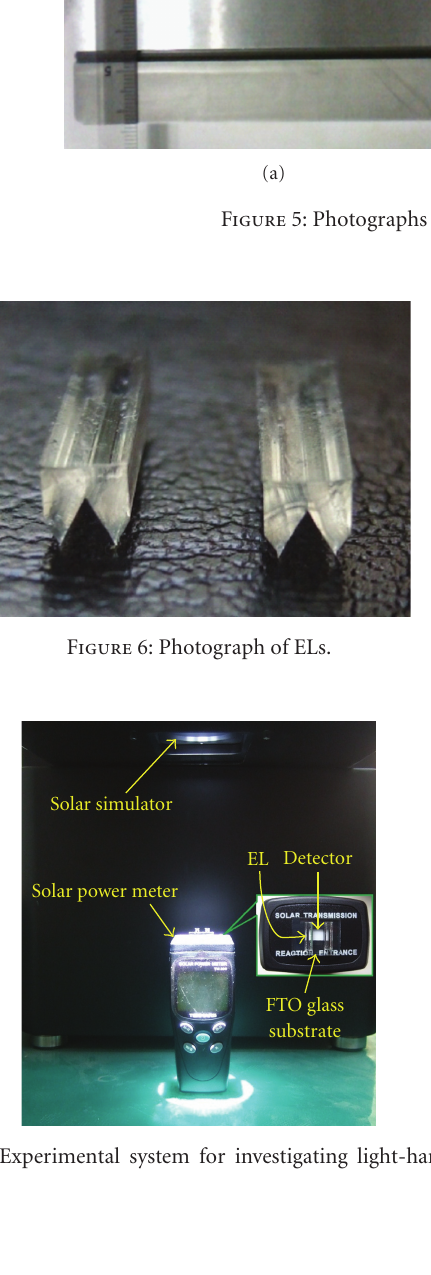
a thickness of approximately 15 μ m. The active area was 0.5 × 0.5 cm 2 .